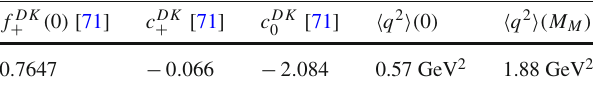
Table6 Parametersenteringourformfactordefinitionsforthesemilep- tonic D → Kn (cid:13) decays, and the value of (cid:9) q 2 (cid:10) ( M 4 ) for M 4 = 0 and M 4 = M M . See text for